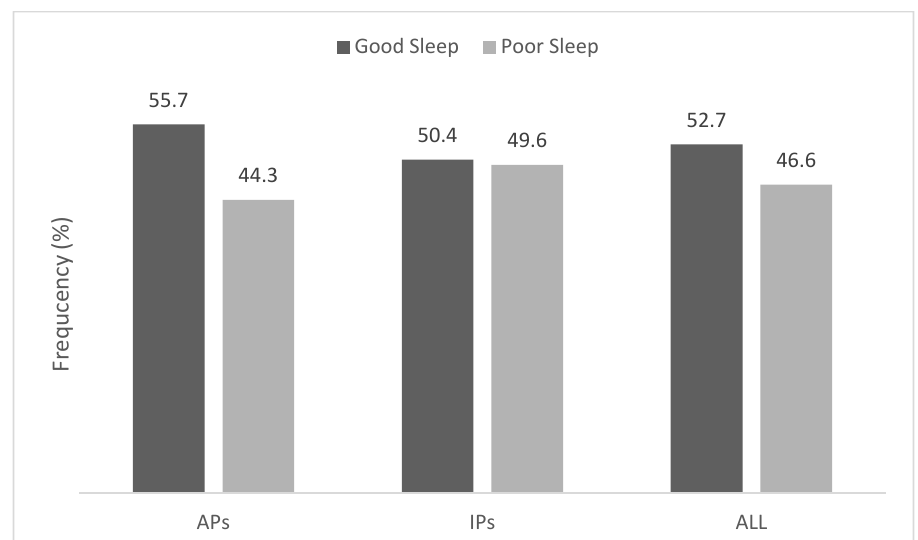
Figure 1. Frequencies of APs and IPs with good and poor sleep quality. Table 3. Anxiety, well-being, and sleep-quality outcomes between IPs and APs.